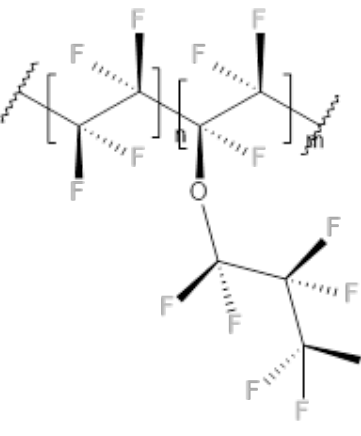
Figure 15. Chemical structure of the PFA.